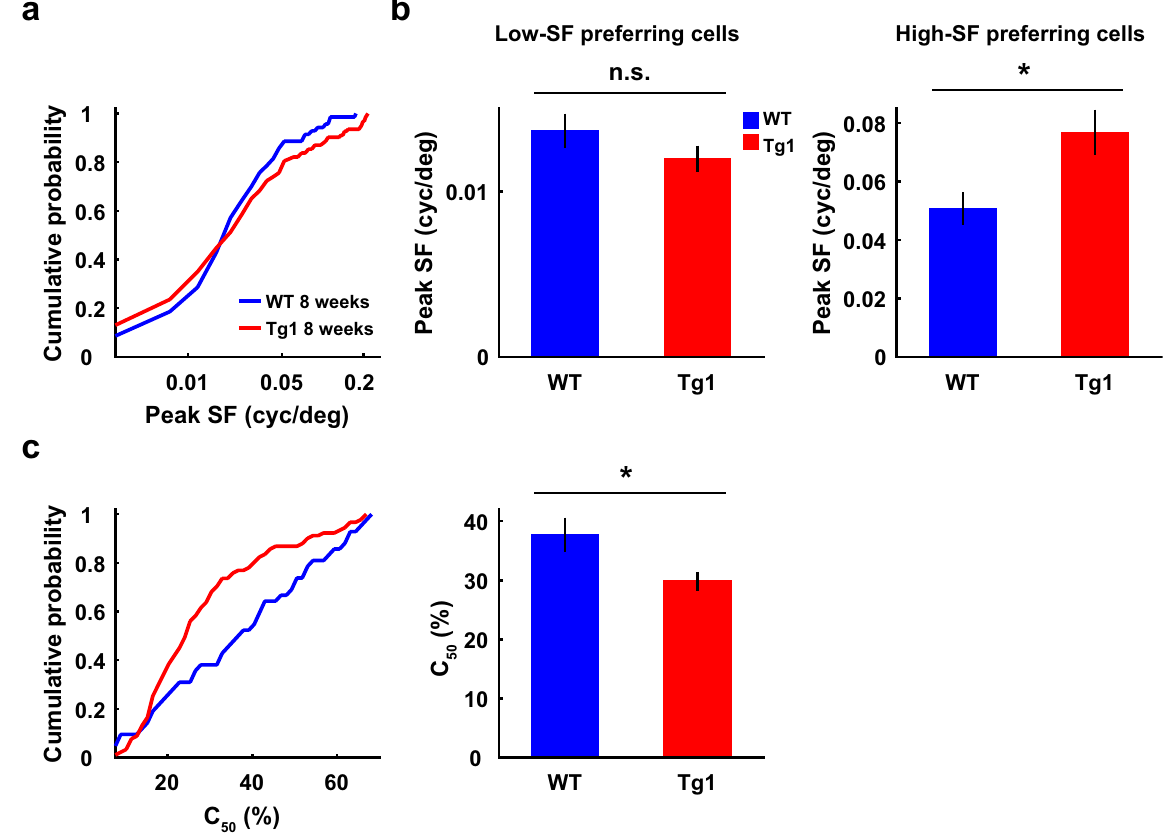
Figure 7. Peak spatial frequency and contrast sensitivity for V1 neurons in mice on a hybrid genetic background. ( a ) Cumulative histograms of peak SFs for V1 neurons in WT and Tg1 mice at 8 weeks. WT: n = 70 neurons from 5 mice; Tg1: n = 124 neurons from 7 mice. ( b ) Left, mean peak SFs for low-SF preferring neurons (n = 34 and 60 for WT and Tg1 mice, respectively). Right, mean peak SFs for high-SF preferring neurons (n = 36 and 64 for WT and Tg1 mice, respectively). ( c ) Left, cumulative histograms of C 50 for V1 neurons in WT and Tg1 mice. Right, the C 50 values of V1 neurons in Tg1 mice were significantly lower than those in WT mice at 8 weeks. WT: n = 42 neurons from 5 mice; Tg1: n = 92 neurons from 7 mice. Error bars, ± s.e.m., * P < 0.05, Wilcoxon rank sum